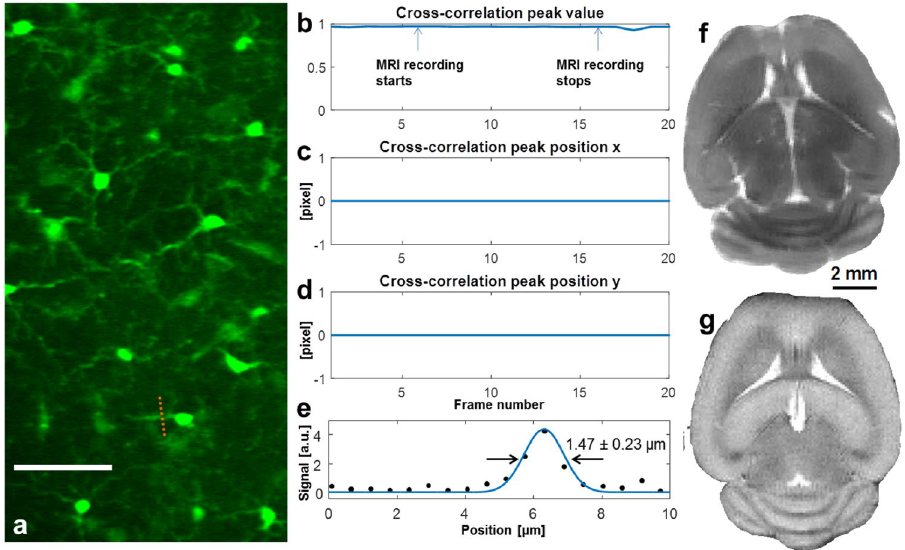
Figure 3. TPM imaging inside the 16.4T MRI magnet. ( a ) TPM images of microglia cells in a fixed CX3CR1 mouse brain (scale bar: 50 μ m). ( b – d ) The cross-correlation peak value and peak positions of the time lapsed TPM images during which we performed MRI recording. The cross-correlation shows that the operation of MRI had no influence on TPM. ( e ) Cross-sectional plot of the process of microglia and its Gaussian fitting (blue line) to determine the FWHM values. ( f ) Ex vivo ultrahigh-resolution spin-echo multiple-slice MRI of the same fixed mouse brain (axial orientation, 117 μ m × 117 μ m in plane resolution, 1 mm slice thickness, and 2 signal averages) acquired at 16.4 T. ( g ) In vivo ultrahigh-resolution mouse brain image (102 μ m × 102 μ m in plane resolution, 0.5 mm slice thickness and 4 signal averages) acquired from a different mouse at 9.4T for